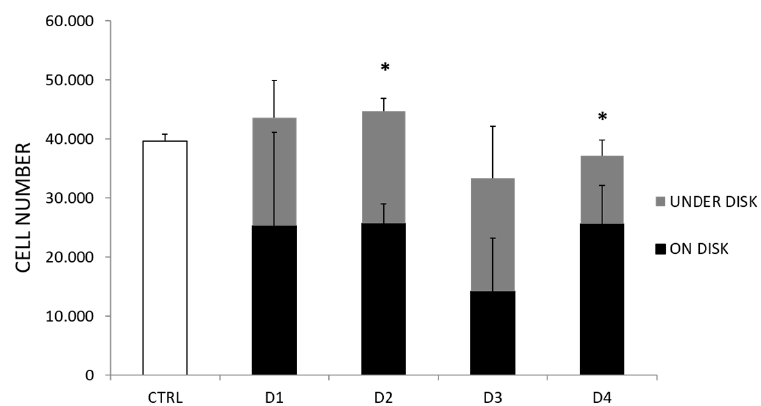
Figure 1. Bichat’s fat pad mesenchymal stem cell (BFP-MSC) growth on Ti disks. Number of BFP- MSCs plated in 12-well culture plates without disks (CTRL), on D1, D2, D3 or D4 for 72 h. Black bars represent live cells counted on disks. Gray bars represent live cells counted under the disks. * Denote statistical significance of cells on disk versus cells under disk (* p <